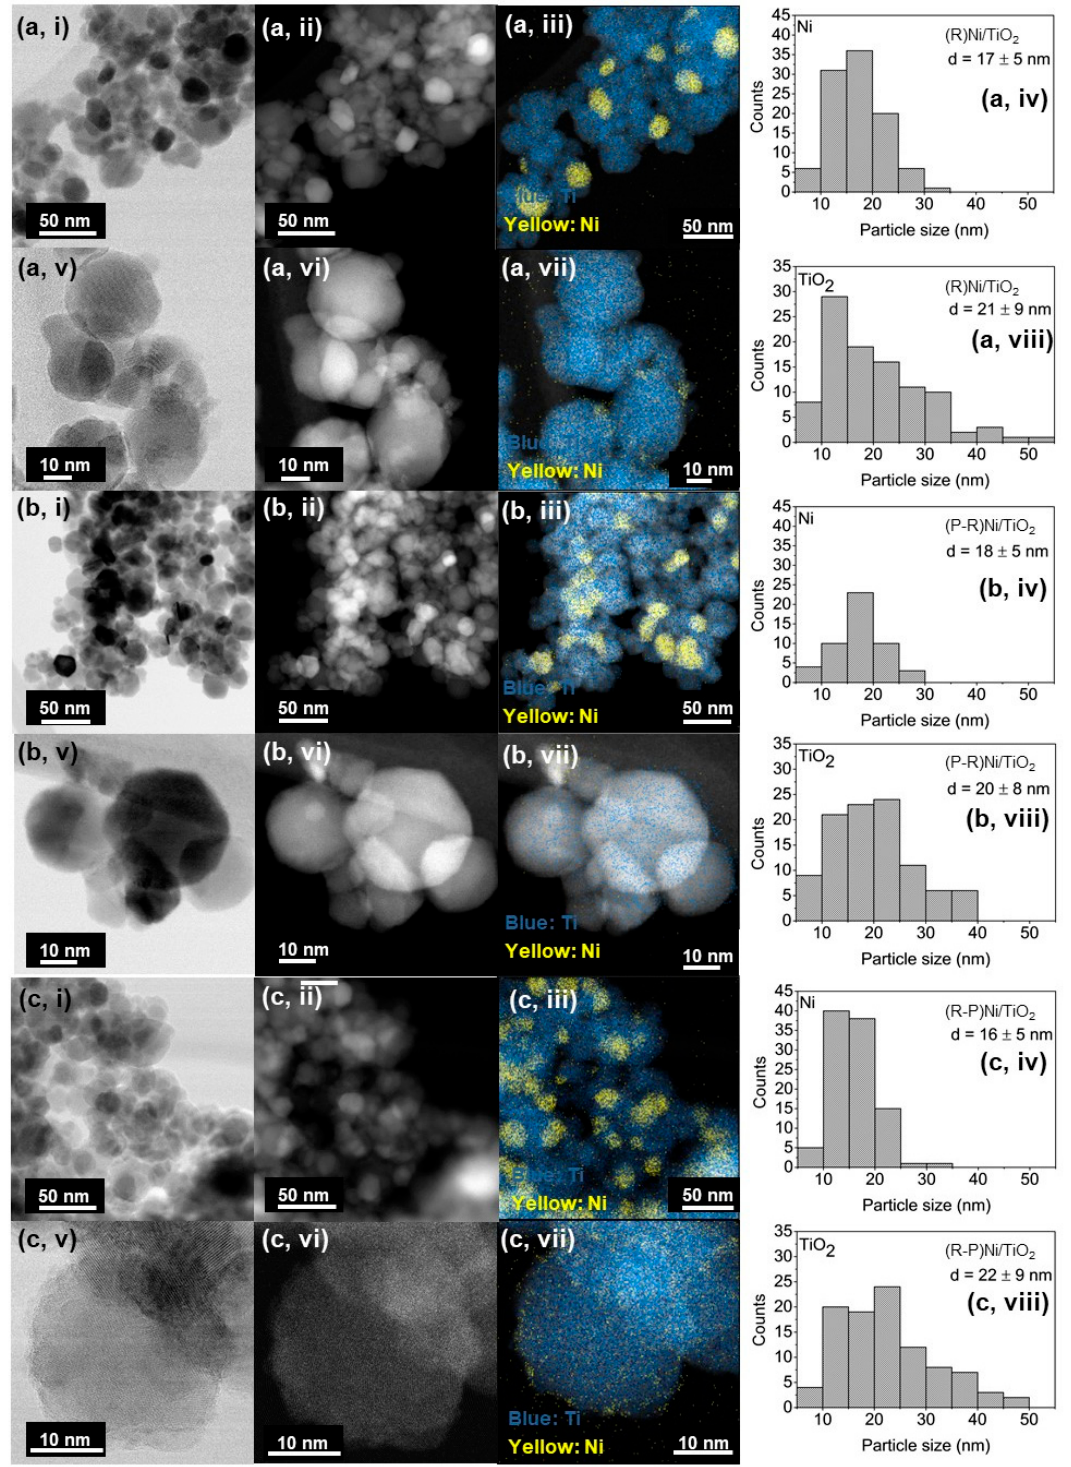
Figure 4. TEM images and EDS mapping of ( a ) (R)Ni/TiO 2 , ( b ) (P-R)Ni/TiO 2 and ( c ) (R-P)Ni/TiO 2 including: ( i , v ) bright field images; ( ii , vi ) dark field images; ( iii , vii ) EDS mapping; and ( iv , viii ) particle size distribution histograms with range of particle counts = 50–100. R = reduced/passivated, P = plasma treated.